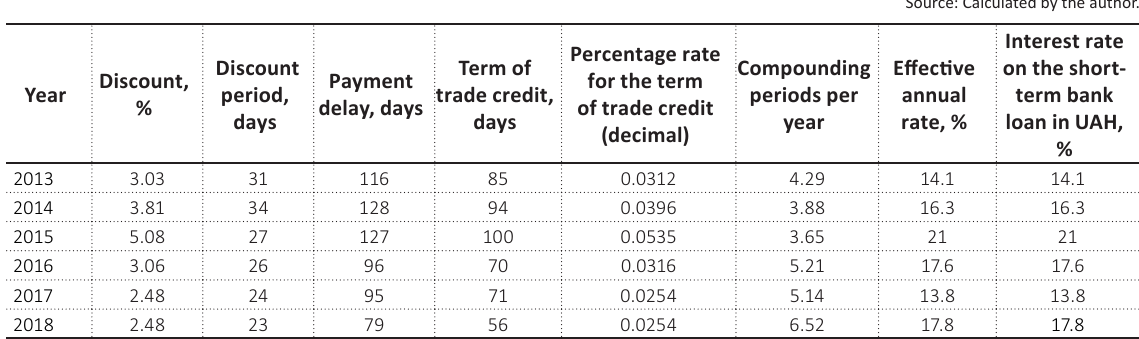
Table 7. The effective annual rate calculation (in case of the short-term bank loan)